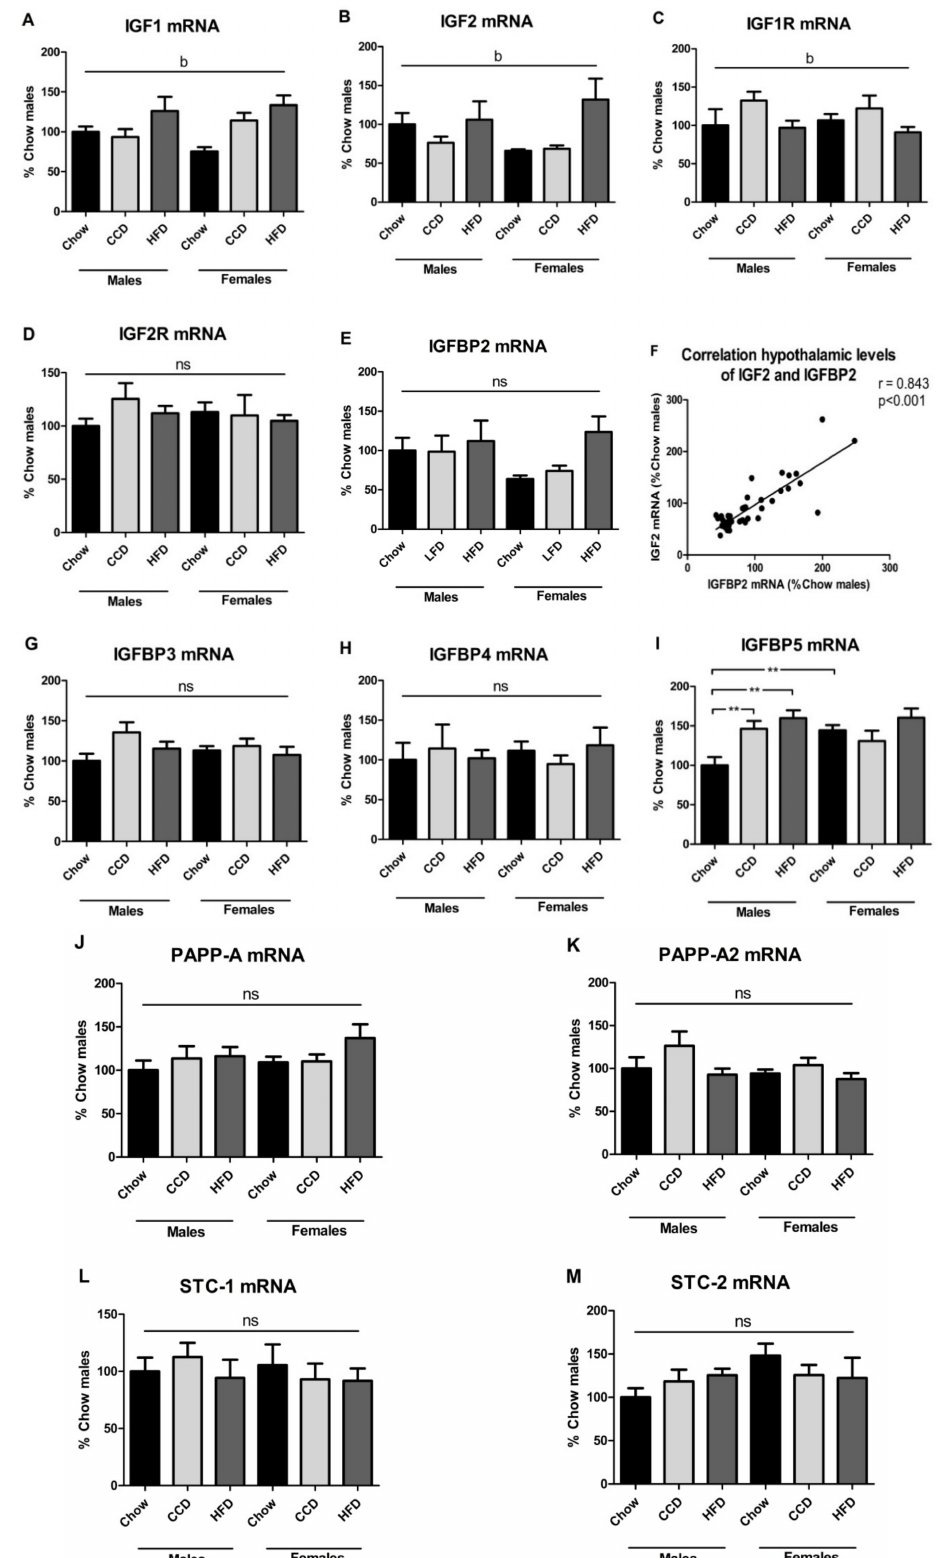
Figure 5. Relative hypothalamic mRNA levels of the IGF system: IGF1 ( A ), IGF2 ( B ), IGF1R ( C ), IGF2R ( D ), IGFBP2 ( E ), IGFBP3 ( G ), IGFBP4 ( H ), IGFBP5 ( I ), PAPP-A ( J ), PAPP-A2 ( K ), STC-1 ( L ) and STC-2 ( M ). Correlation of relative hypothalamic mRNA levels of IGF2 and IGFBP2 ( F ). ** p < 0.01, b: e ff ect of diet, ns = non-significant, HFD = high-fat diet, CCD = commercial control diet, n =